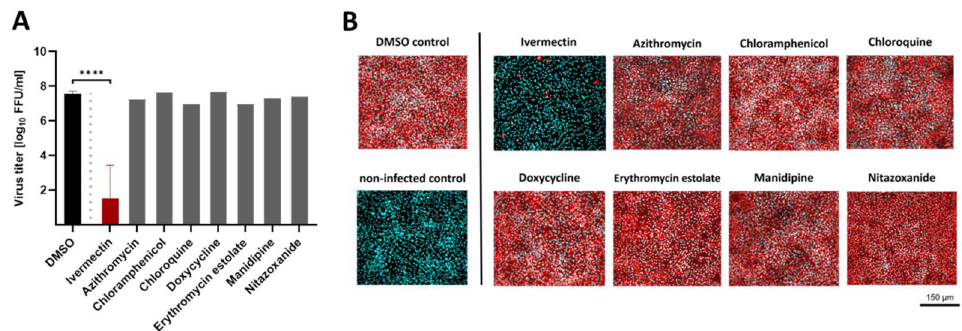
Figure 2. Screening of approved compounds for antiviral activity against USUV by titration of virus infectivity with a focus-forming assay. Several pharmacological molecules were screened for inhibitory efficacy against USUV lineage Africa 3 in reference cell line Vero CCL-81 at MOI of 0.1. ( A ) Extracellular infectious virus was quantified from supernatants by virus titration performing focus-forming assay. ( B ) Distribution of intracellular flavivirus antigen was evaluated by immunofluorescence analysis with a flavivirus-specific antibody. Flavivirus antigen is shown in red and nuclei stained with DAPI are shown in cyan blue. All results are demonstrated at the representative maximum concentration of 5 µM. Statistical significance is indicated as **** ( p < 0.0001).